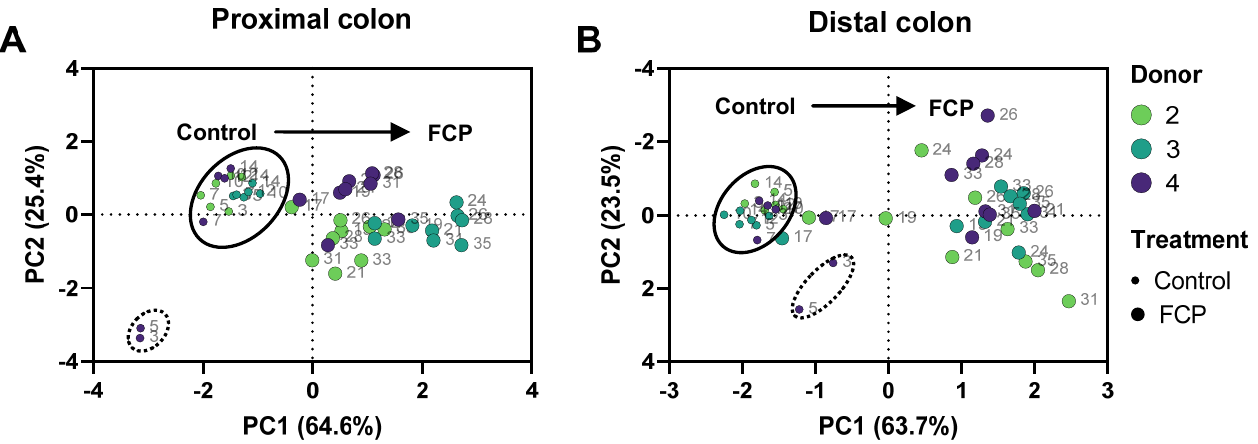
Figure 4. Principal component analysis (PCA) based on microbial metabolic activity in the proximal ( A ) and distal ( B ) colon during the control and treatment with FCP, as tested for three human adult donors 2, 3, and 4 in the triple-M-SHIME. The PCA is based on the individual values for each donor and for each time point (three samples per week during five experimental weeks: two control weeks (3/5/7/10/12/14) and three treatment weeks (17/19/21/24/26/28/31/33/35)). The following data were included: acetate, propionate, butyrate, and bCFA. Arrows indicate the evolution of samples along the duration of the experiment.